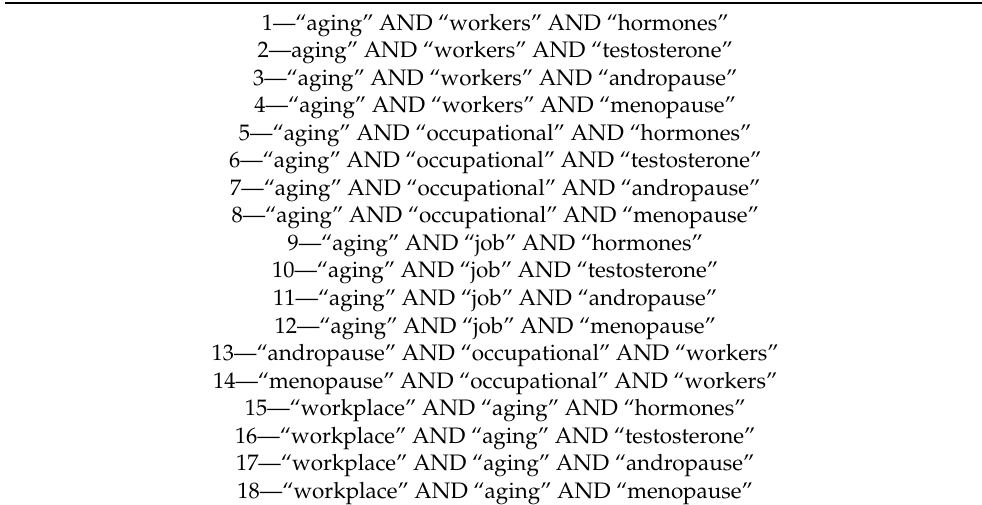
Table 1. Search strategy adopted to identify relevant